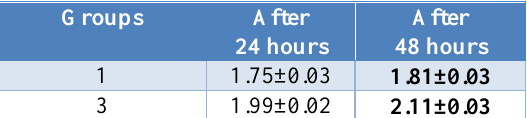
Table, 1: Show mean thickness of skin against SSCAgs in immunized animals at 24- 48hrs post